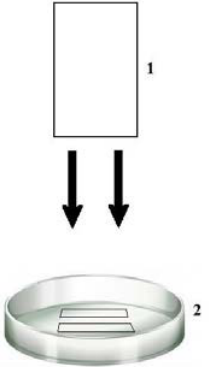
Figure 13. The scheme of the laser experiment; 1—laser and 2—two pieces of the bandage. The frequency selected in the study is determined by the frequency of plasmon resonance of AgNPs, the power and time of the exposure are determined experimentally. Statistical processing of the results was carried out using the program Statistica 10.0. The given 5% significance